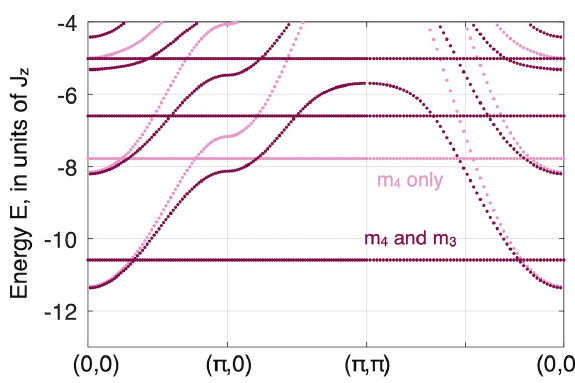
Figure 16: Two-hole spectrum as in Fig. 6, showing only data for fermionic holes. We compare results from the truncated basis with all m to results from a further reduced basis including only m n (light dots). In both cases we used a maximum string length ℓ = 3 with a string potential for an Ising background. considered t / J z